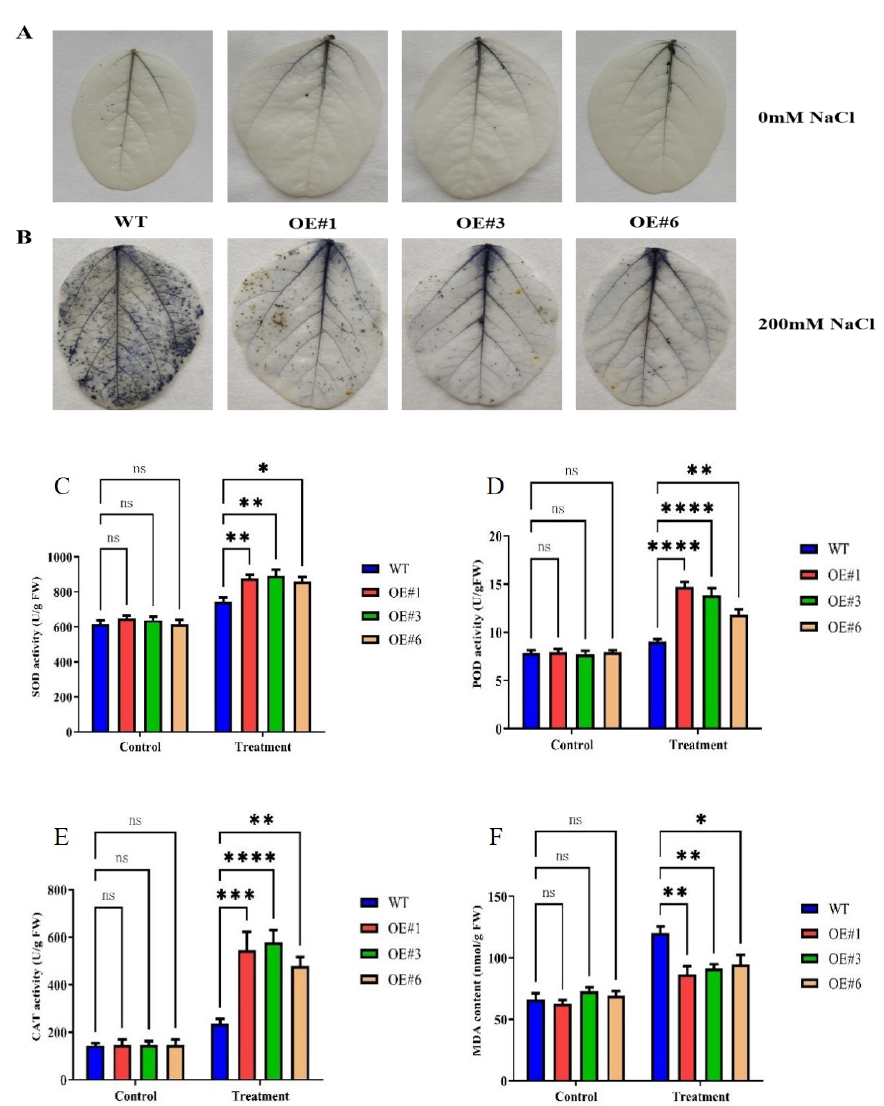
Figure 2. Phenotype ( A , B ), SOD activity ( C ), POD activity ( D ), CAT activity ( E ), and MDA content ( F ) of control (0mM NaCl) and salt ‐ treated (200mM NaCl) soybean seedling leaves after 36 h. Note: A group–group significance analysis was performed, and each treatment (OE#1, OE#3, and OE#6) was compared to WT. All values are presented as the mean ± SD of three independent experiments. * p < 0.05, ** p < 0.01, *** p < 0.001,**** p < 0.0001.